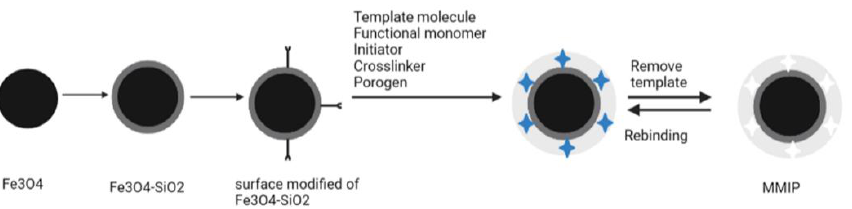
Figure 4. Schematic illustration of magnetic molecularly imprinted polymer (MMIP) synthesis.